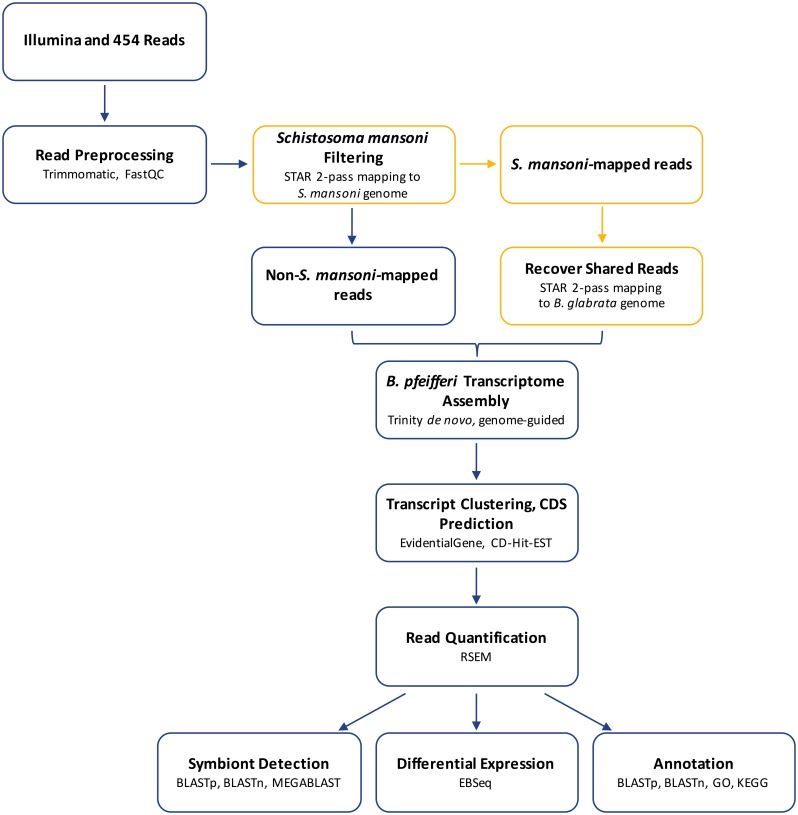
Overview of novel bioinformatics pipeline developed to isolate and analyze B. pfeifferi transcriptomic expression from dual RNA-Seq data.